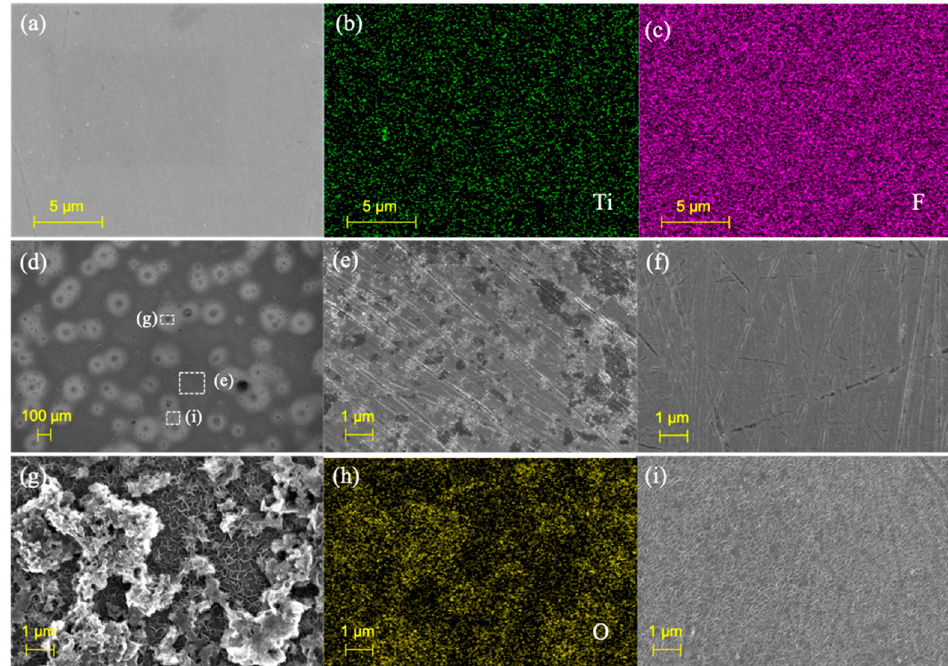
Figure 3. ( a , d ) Morphology; ( b , c ) Element distributions of the MXene coatings deposited on pipe steel; ( e , g , i ) Surface SEM images of the local area in ( d ); ( f ) Surface SEM image of the steel substrate; ( h ) EDS image of ( g ).